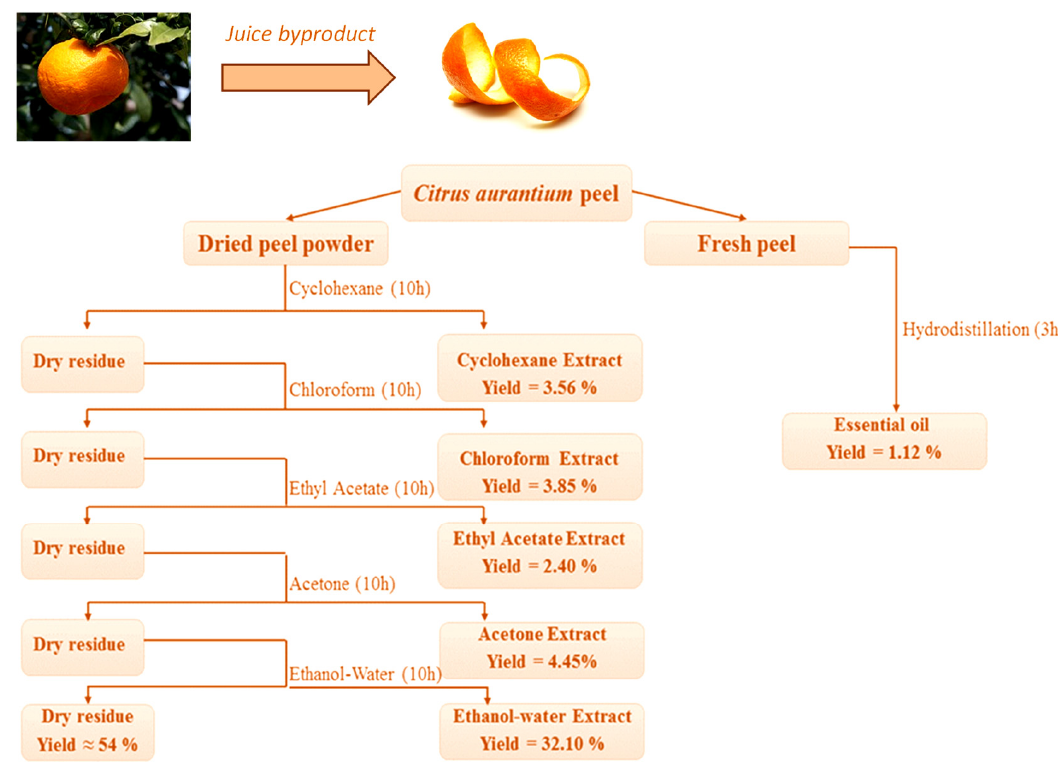
Figure 1. Extraction process and extraction yield by different solvents (cyclohexane, chloroform, ethyl acetate, acetone, and ethanol-water) from C. aurantium peel. Hydrodistillation of essential oil from the fresh peel.